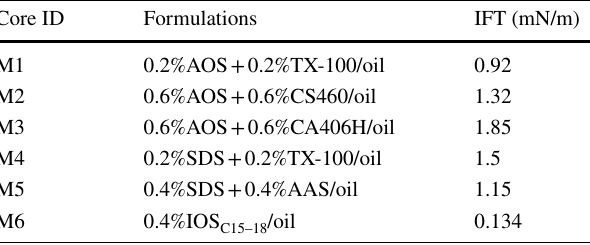
Table 7 Interfacial tension of tested surfactant